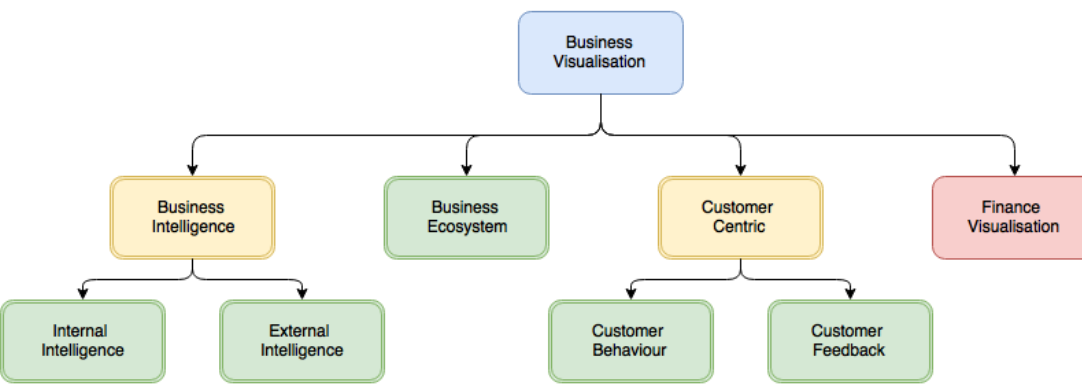
Figure 1. The top level hierarchical classification of the literature survey. Green classifications represent leaf nodes, while yellow represents umbrella classifications (see Section 1.1). Financial visualisation (red) is closely linked to this field, but has been published as a survey by Ko et al.